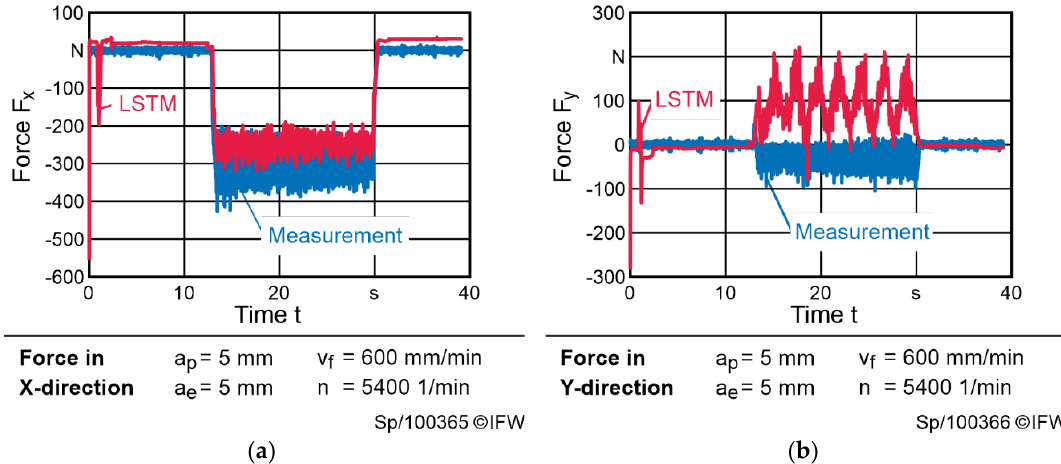
Figure 8. Comparison between measured process forces and the result of the LSTM during side milling in negative X -direction: ( a ) force acting in X -direction; ( b ) force acting in Y -direction.